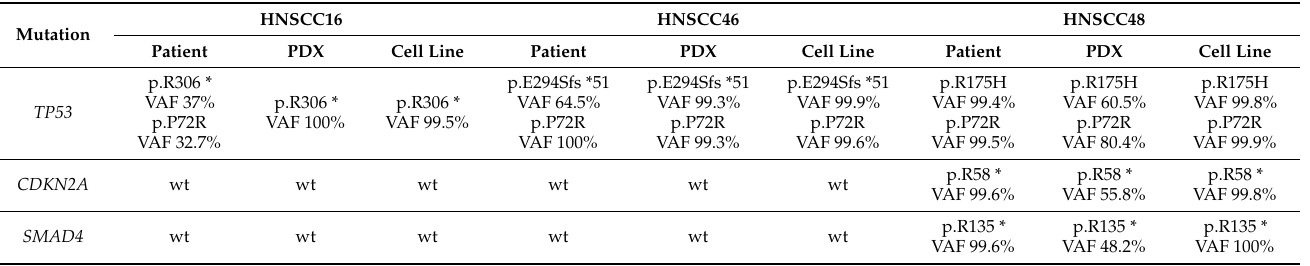
Table 2. Comparative analysis of mutational profile between patients’ tumor, the corresponding PDX and cell line.